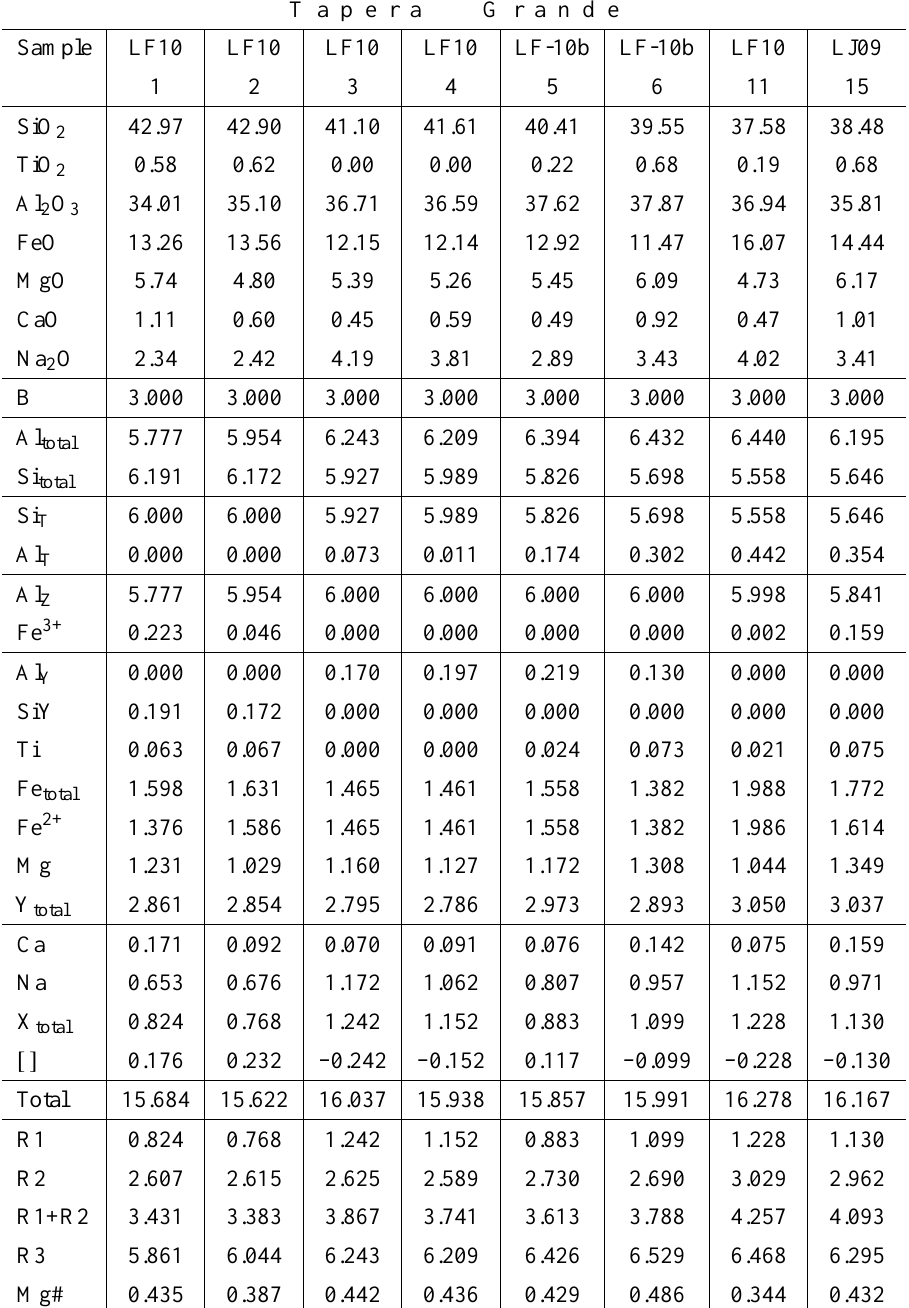
EDS-SEM analyses of tourmalines from Tapera Grande and Quartzito. Structural formulae calculated on 31 oxygen